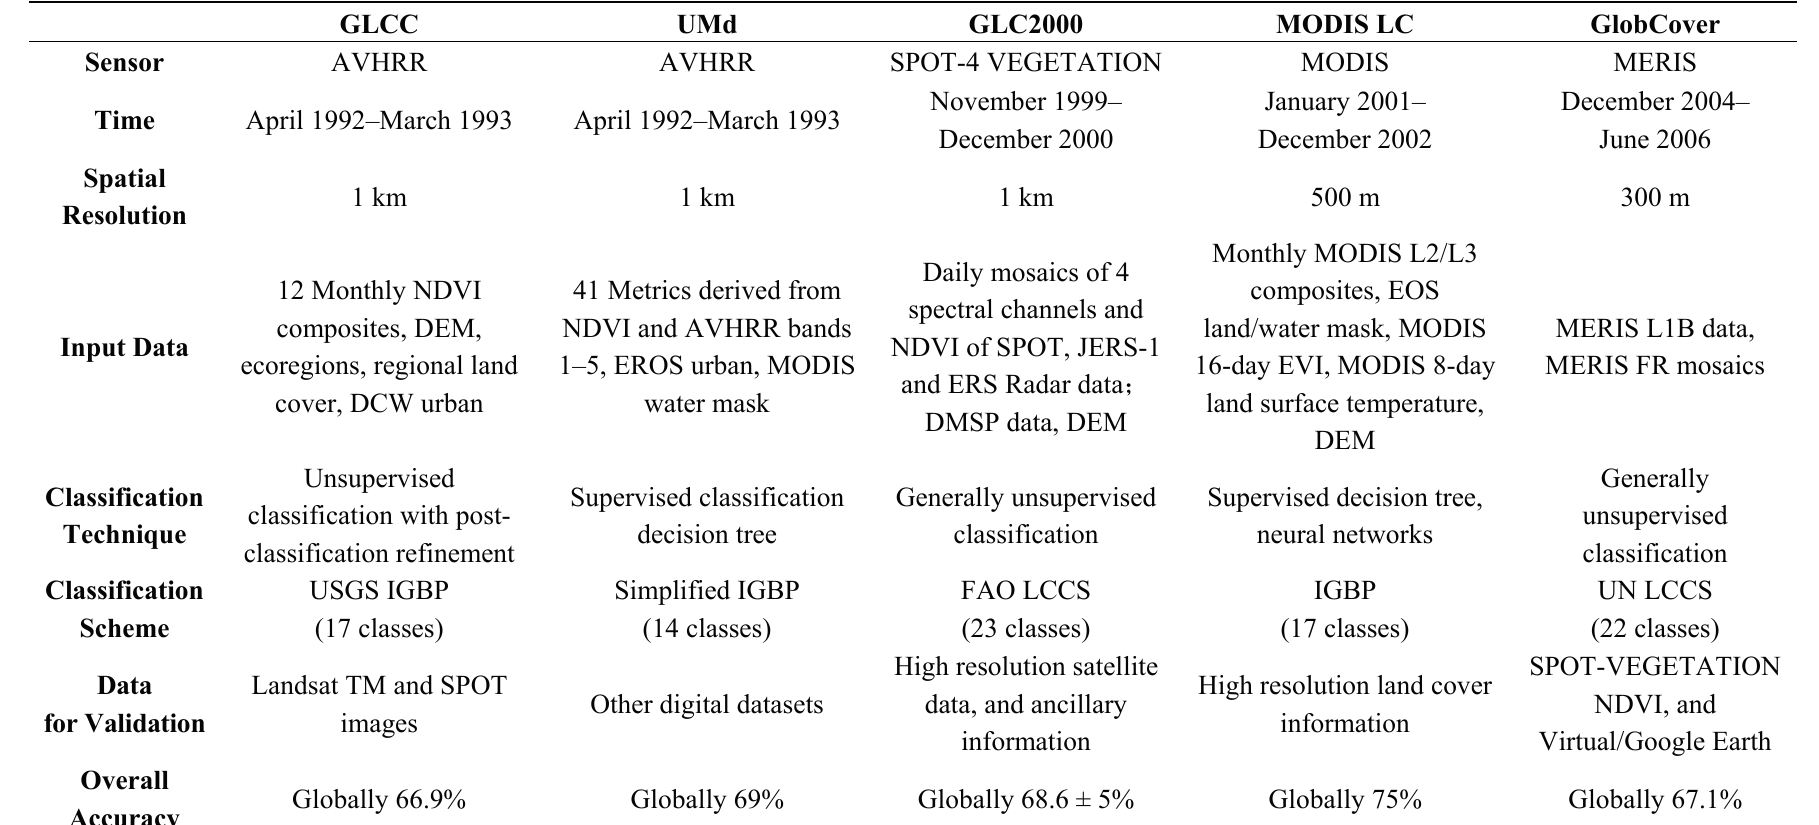
Table 1. Characteristics of the five global land cover data sets assessed in this